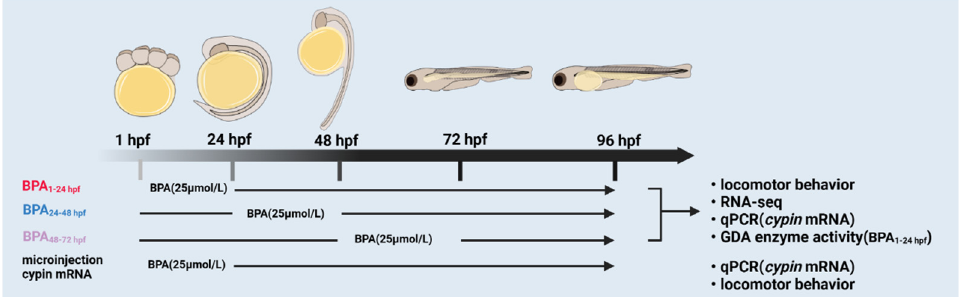
Figure 1. A workflow of the present study design.